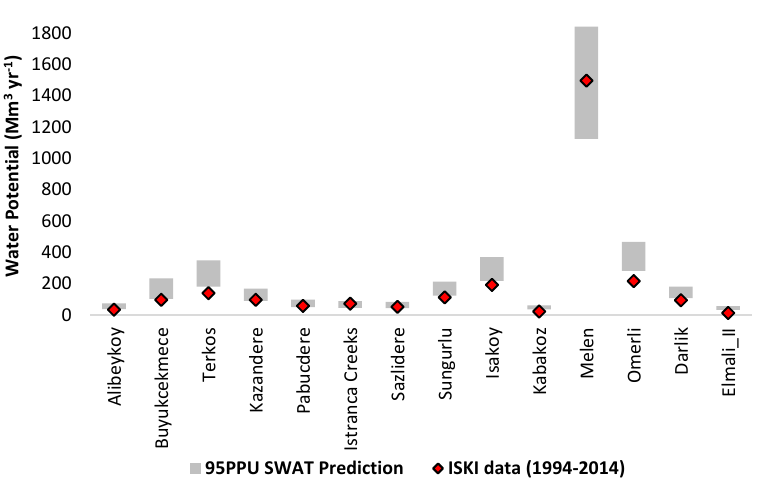
Figure 11. Comparison of the simulated 95PPU SWAT prediction (1980–2013) for water potential with the available data from the Istanbul Water and Sewerage Administration (ISKI) for the watersheds of Istanbul.